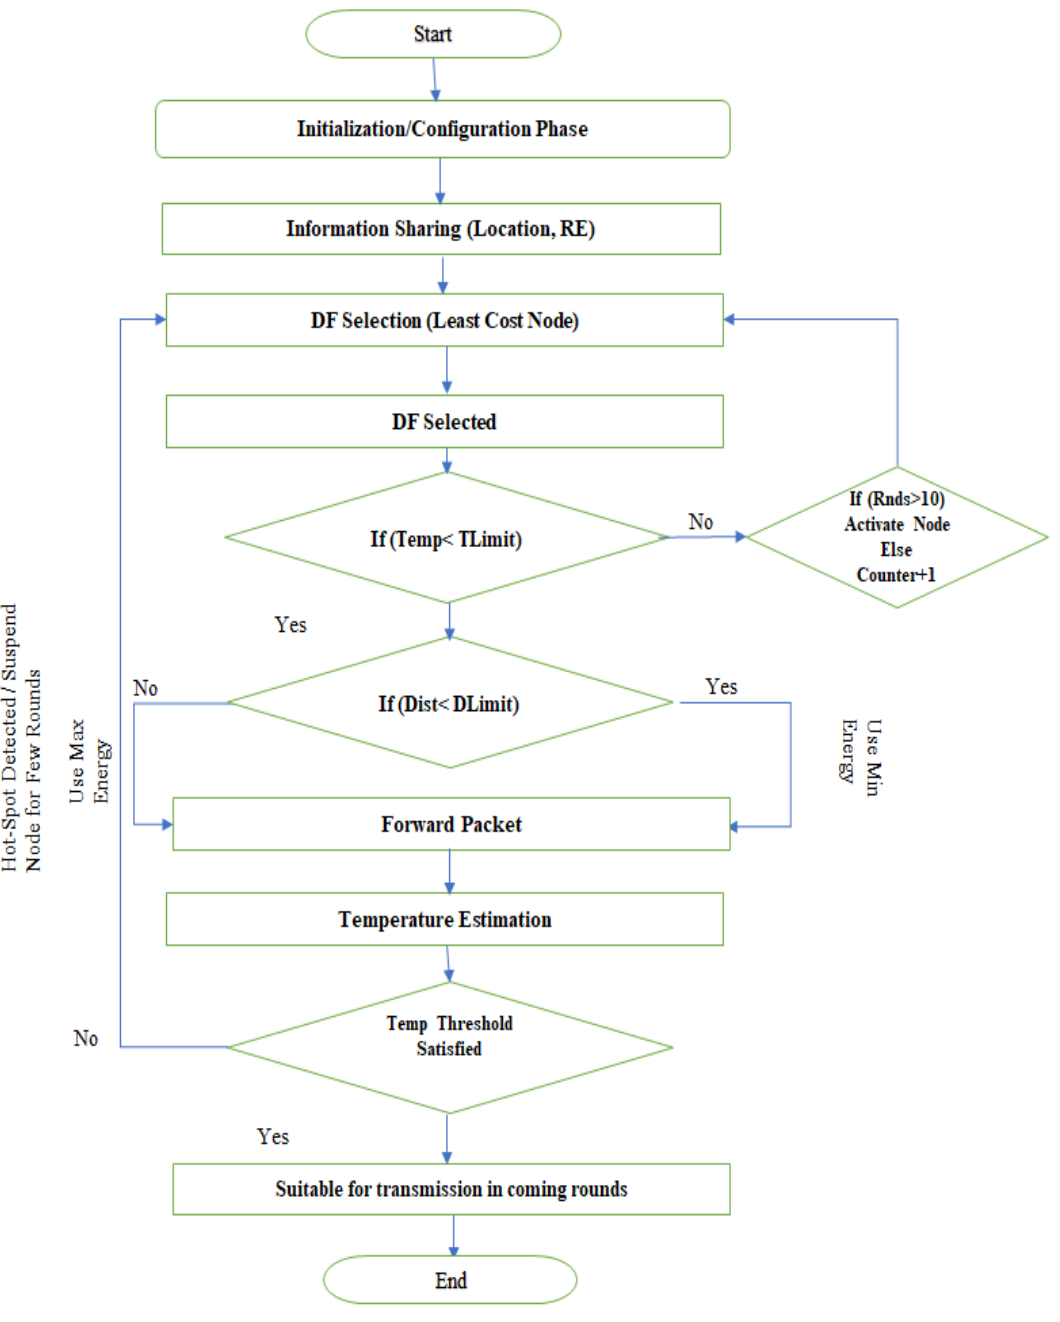
Figure 2. Operational Flow Diagram.